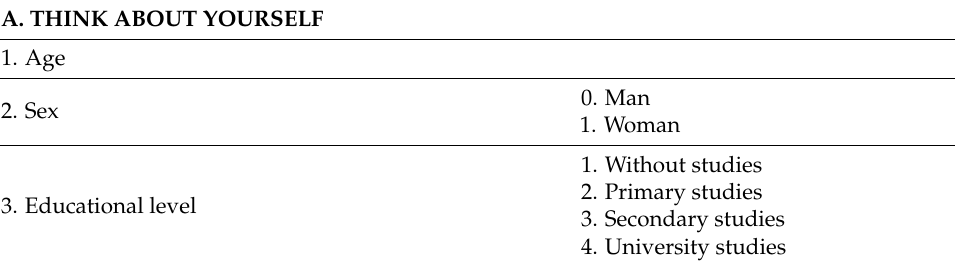
Table A1. Questions from the sociodemographic profile